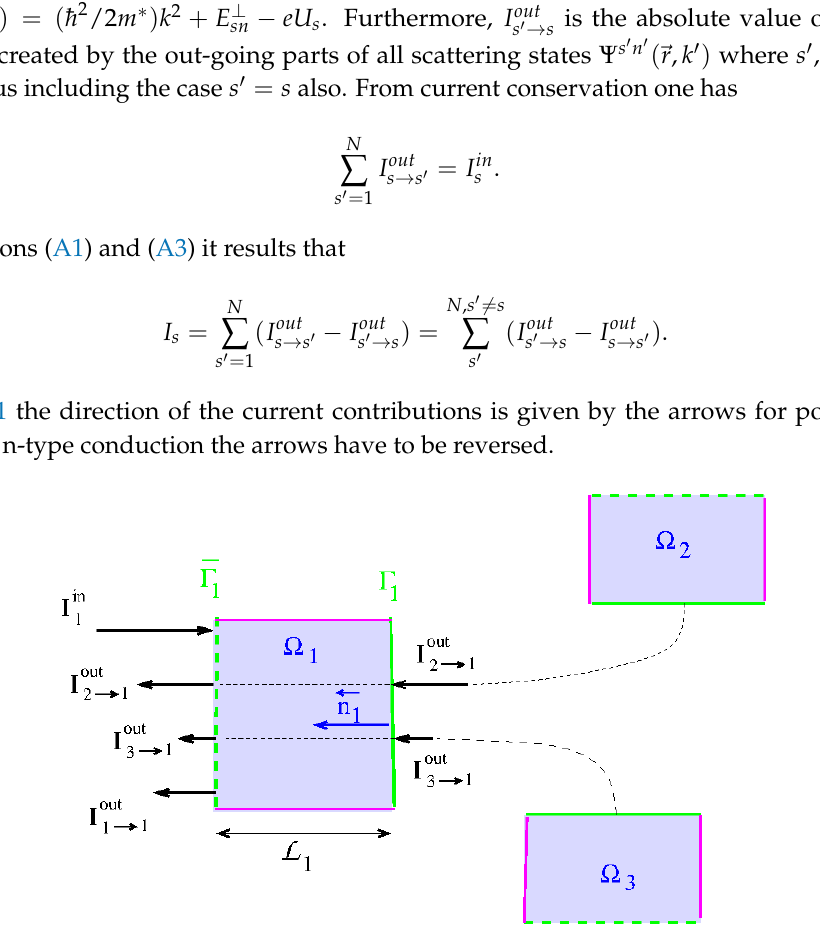
Figure A1. The formulation of Equation (A1) for contact s = 1 in a N = 3-terminal device at ¯ Γ 1 (see also Figure 1). The current component directed in − (cid:126) n 1 -direction is I in in (cid:126) n 1 -direction are I out , I out , and I out . Because there are no scattering processes in Ω 1 it holds that 1 → 1 1 → 2 1 → 3 I out and I out are the same in Γ 1 and ¯ Γ 1 (see dashed horizontal 1 → 2 1 → 3